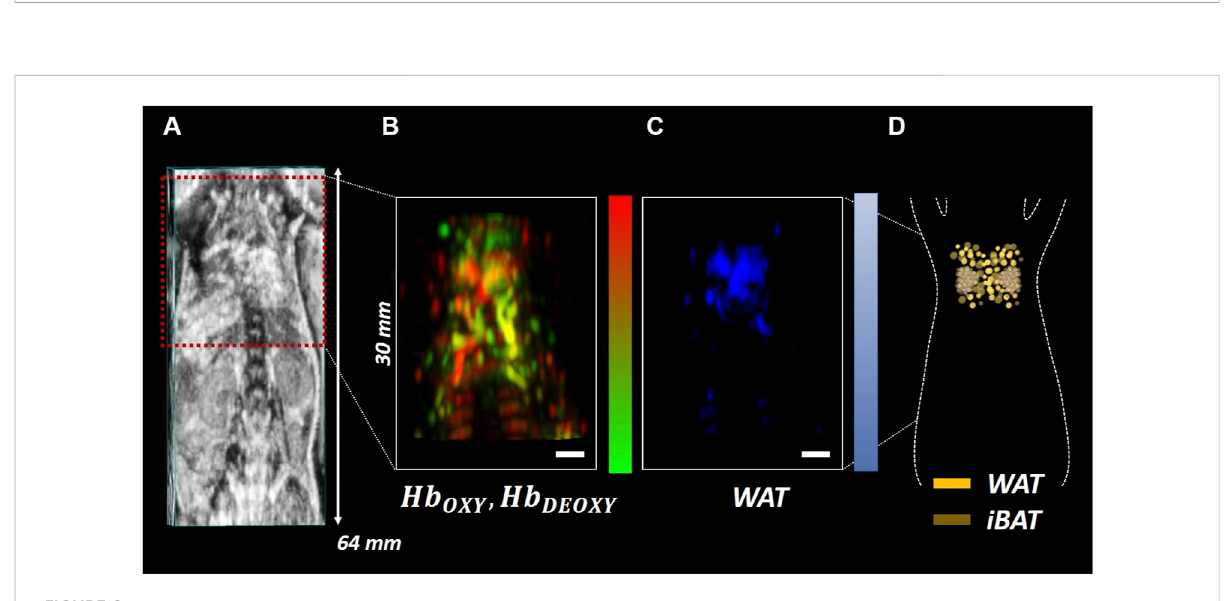
FIGURE 8 Whole-body US image of the mouse in a prone position with the cervical-thoracic area highlighted by the red ROI (A) ; Oxy/deoxy hemoglobin (B) and WAT (C) abundance maps obtained via SPAX depicted in red/green and blue respectively. Schematic of a mouse interscapular adipose tissue including WAT and iBAT (D) . The scale bar size is 2